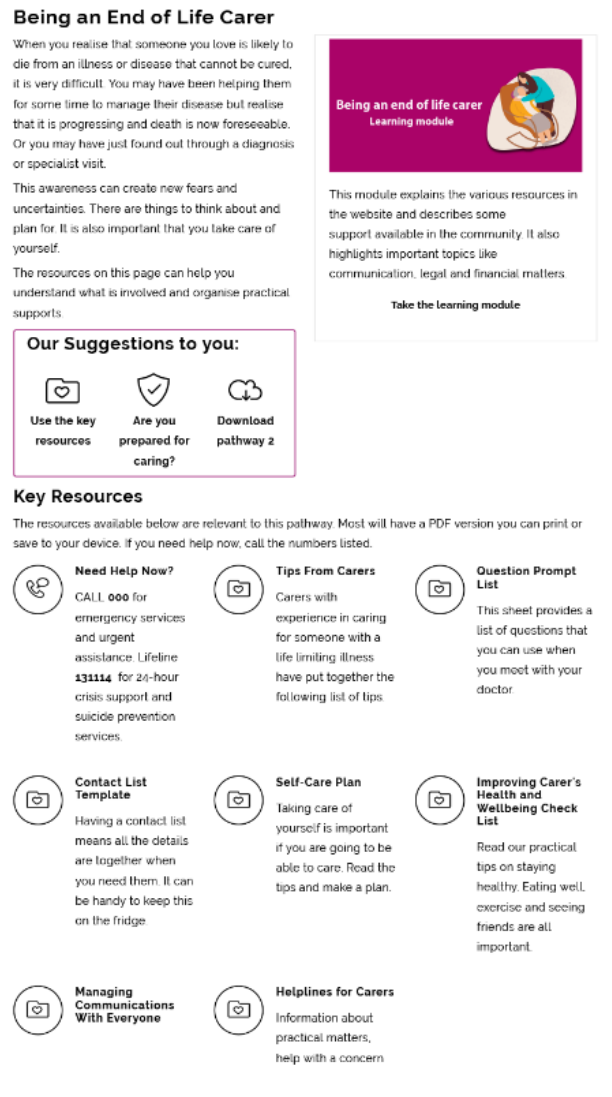
Figure 2. An example of the internal content page of the Carers Toolkit prototype.